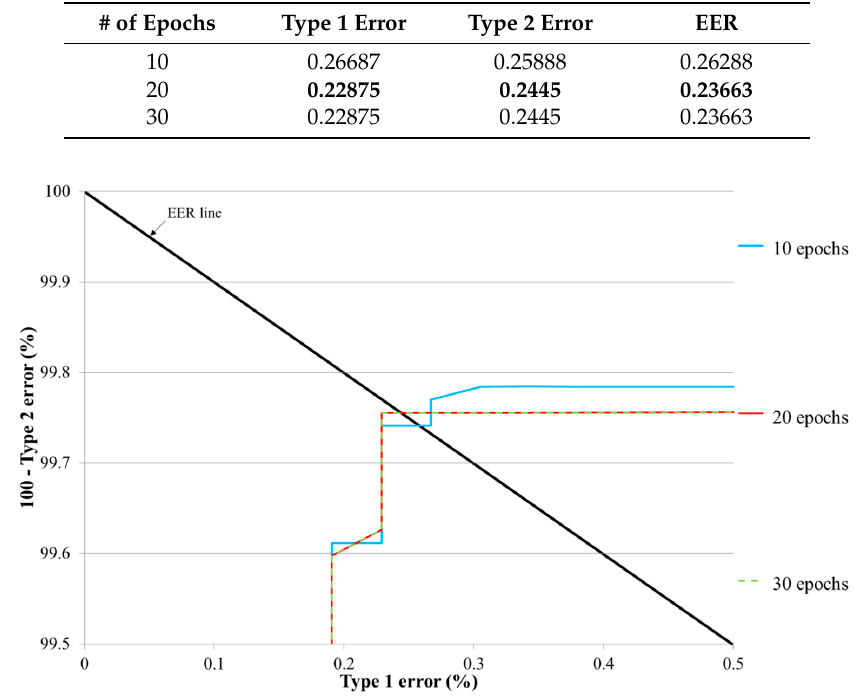
Figure 7. ROC curves for the testing data using the proposed CNN based on the number of training epochs.